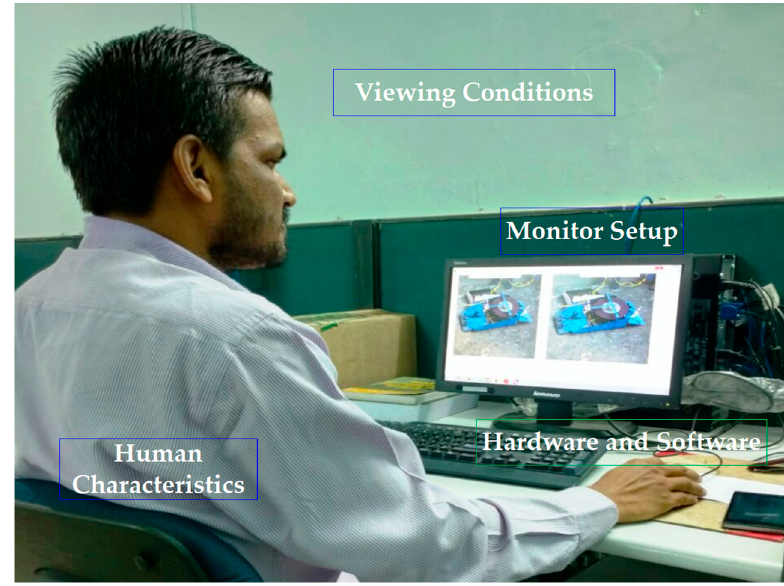
Figure 7. Example of subjective test and its setup.